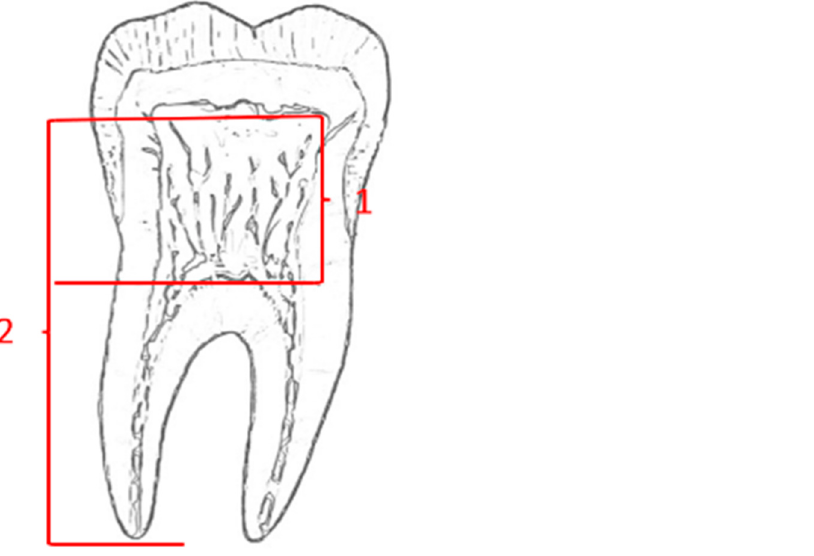
Figure 1. Taurodontism variables by Shifman and Chanannel 1978.